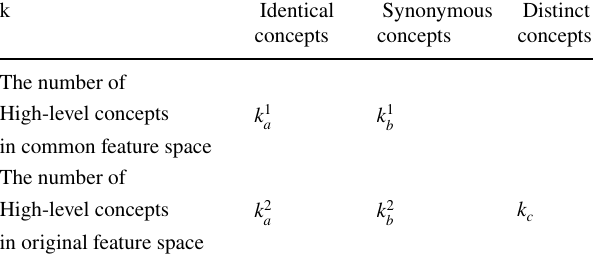
Table 3 Number of high-level concepts learned in DSTL